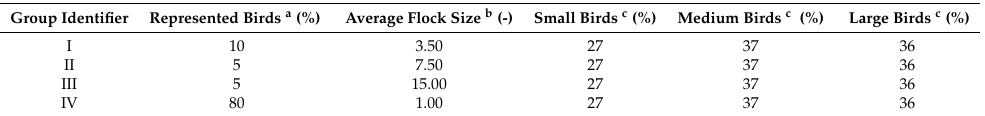
Table 5. Determined flock size groups within the range of the weather radar (200 m–1000 m) during night time. Group IV represents individually flying